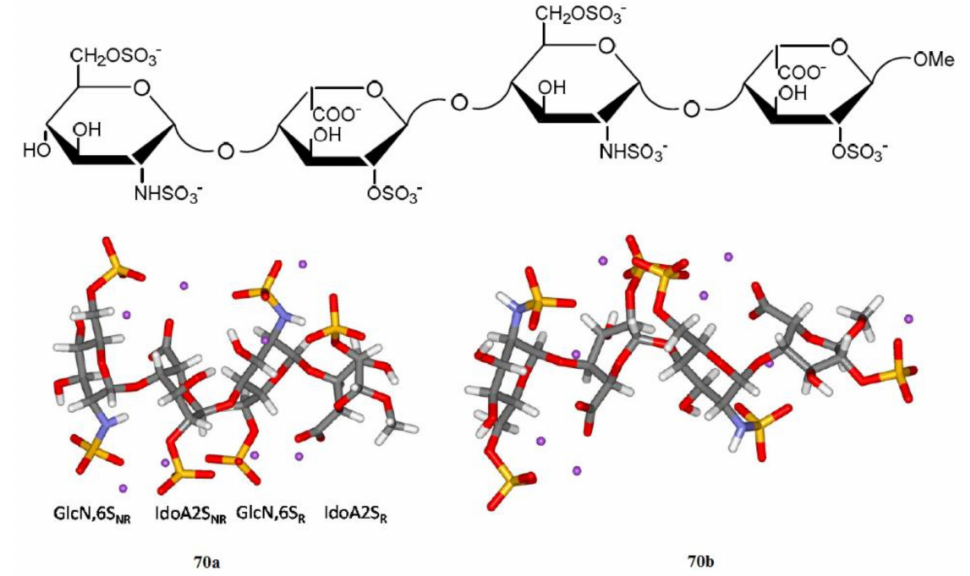
Figure 35. The DFT optimized structure of the heparin tetrasaccharide. The two forms, 70a and 70b , have different conformations of the IdoA2S residue. The IdoA2S residues are in the 1 C 4 conformation in 70a and in the 2 S 0 conformation in 70b . The GlcNS,6S residues are in the 4 C 1 conformation. Violet dots represent sodium ions. Solvent (water) molecules are not shown for clarity. The fully optimized molecular structures of two predominant tetrasaccharide conformations of the sulphated iduronic acid residue were obtained at the B3LYP/6-311+G(d,p) level and with applying explicit water molecules to simulate the presence of a solvent. Reproduced from Hricov í ni and coauthor [147] under an open access Creative Commons Attribution 4.0 International Public License. Vicinal proton- proton coupling constants of heparin tetrasaccharide presented in Table 4 showed that the best agreement of the performed calculations with experiment was obtained with a weighted average of 1 C 4 and 2 S 0 conformations of 67:33 for the IdoA2S forms. Detailed analysis of the Fermi-contact terms of 3 J (H-C-C-H) demonstrated that important contributions originated from the lone pairs of the neighbouring oxygen atoms. Performed calculations also showed that magnitude of the diamagnetic spin-orbit contributions were sufficiently large as compared to the total values of proton-proton coupling